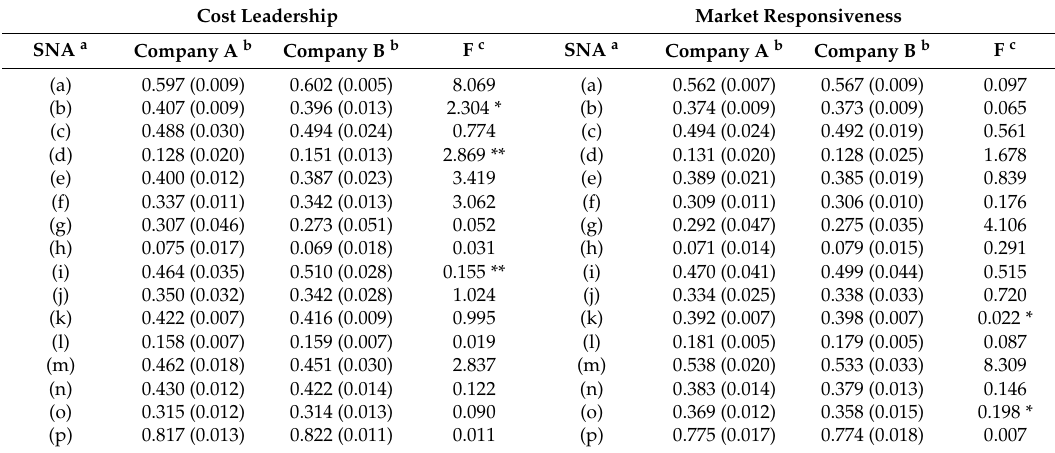
Table 10. Panel 2 comparison